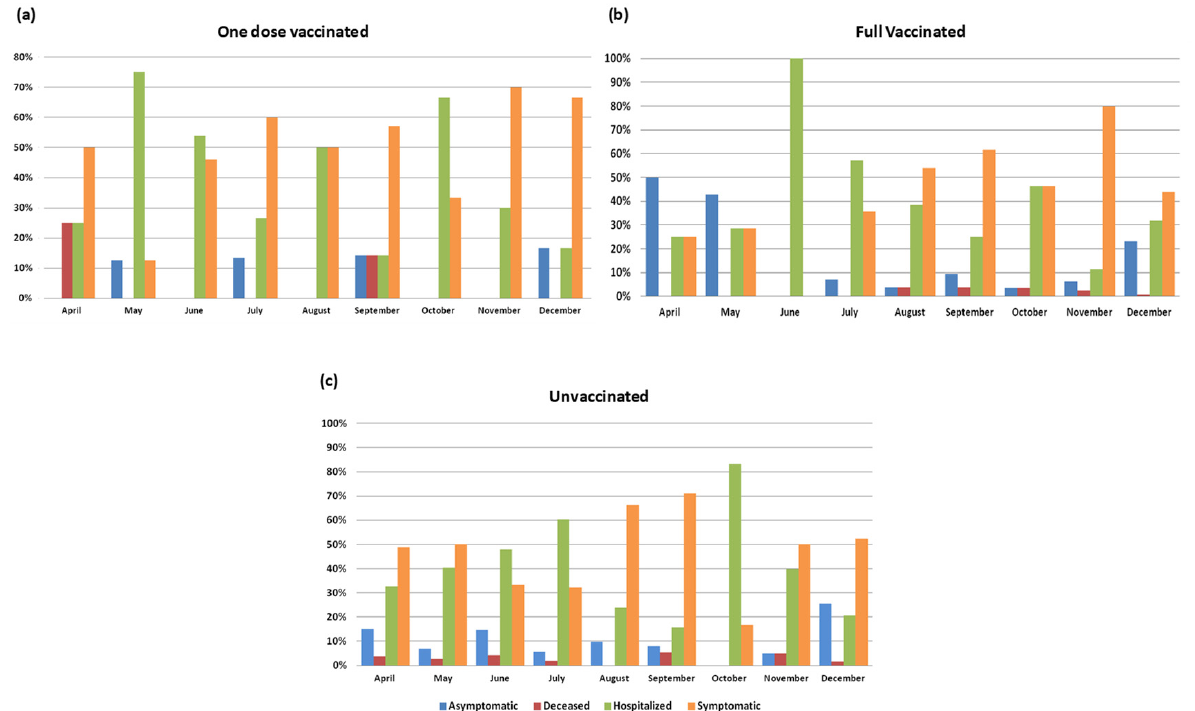
Figure 4. Clinical status/outcome in ( a ) subjects vaccinated with one dose, ( b ) subjects vaccinated with two or three doses, and ( c ) unvaccinated subjects during the study period. In the subset of patients with known vaccination and clinical status ( n = 772), significant differences according to viral variant were observed only among the vaccinated subjects ( n = 393, p < 0.001). The vaccinated symptomatic patients were more frequent (61.1%) among those with the Delta variant infection, while the hospitalised subjects were more frequent in those infected with the Alpha variant (55.6%). As already observed in the whole cohort, the vaccinated subjects with the Gamma variant presented the highest proportion of asymptomatic status (41.7%) but also of deaths (8.3%). No death was observed in the vaccinated subjects carrying the Alpha and the Omicron variants (Figure 5).